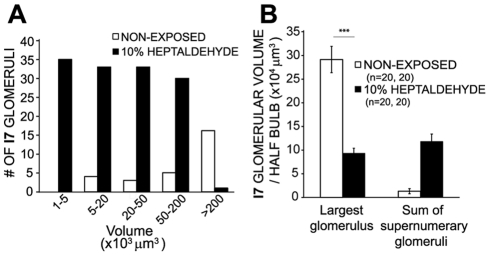
Chronic odorant exposure led to the redistribution of the glomerular volume.The graph in A shows a volume histogram of the total population of I7 glomeruli in 20 half bulbs of non-exposed mice and in those exposed to 10% heptaldehyde. The bar graph in B depicts the average volume of the largest I7 glomerulus per half bulb and the average sum of the volume of I7 supernumerary glomeruli per half bulb in non-exposed mice and in those exposed to 10% heptaldehyde. Kruskal-Wallis sum rank test: p<0.01 followed by Dunn multiple comparison test: ***, P<0.001.